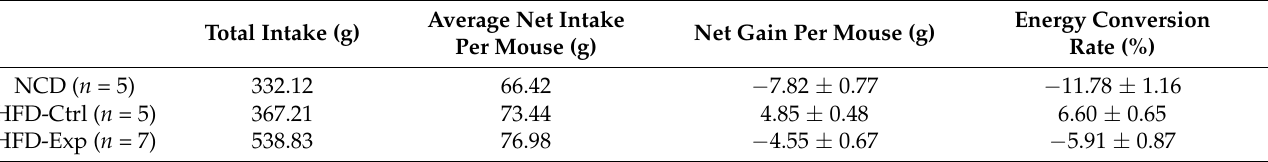
Table 3. Food intake and energy conversion efficiency from day 1 to day